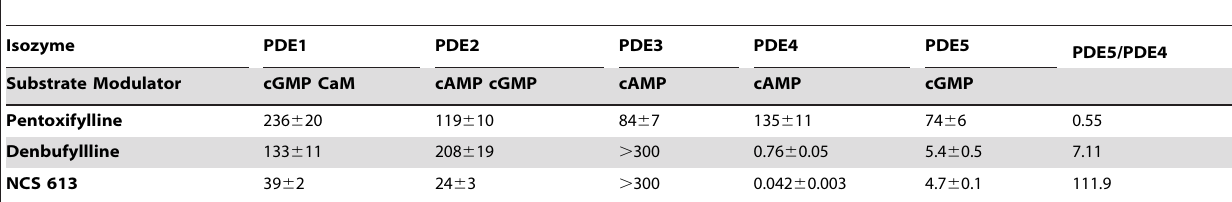
IC 50 values were determined at 1 m M substrate concentration in the presence of the modulator for PDE1 and PDE2 and represent the mean 6 s.e.m. of three independent experiments. CaM=calmodulin.